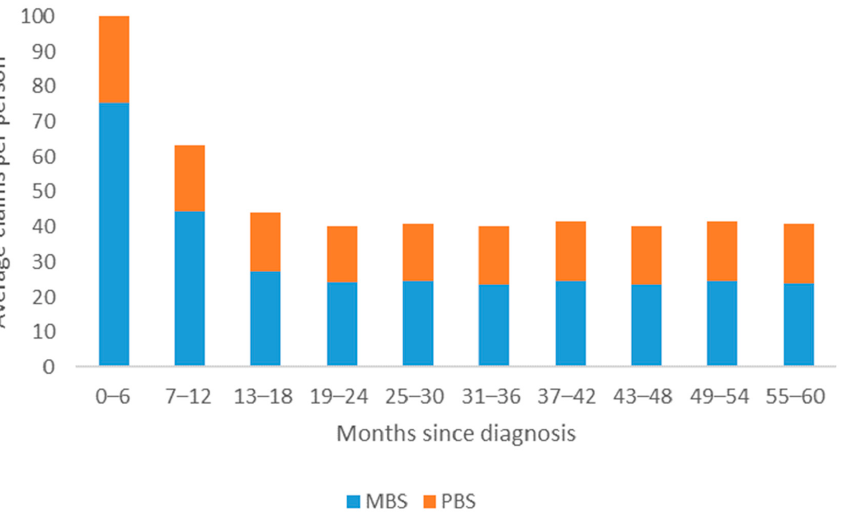
Figure 3. Average number of MBS and PBS items claimed per person over five years for females diagnosed with breast cancer in Queensland, Australia.